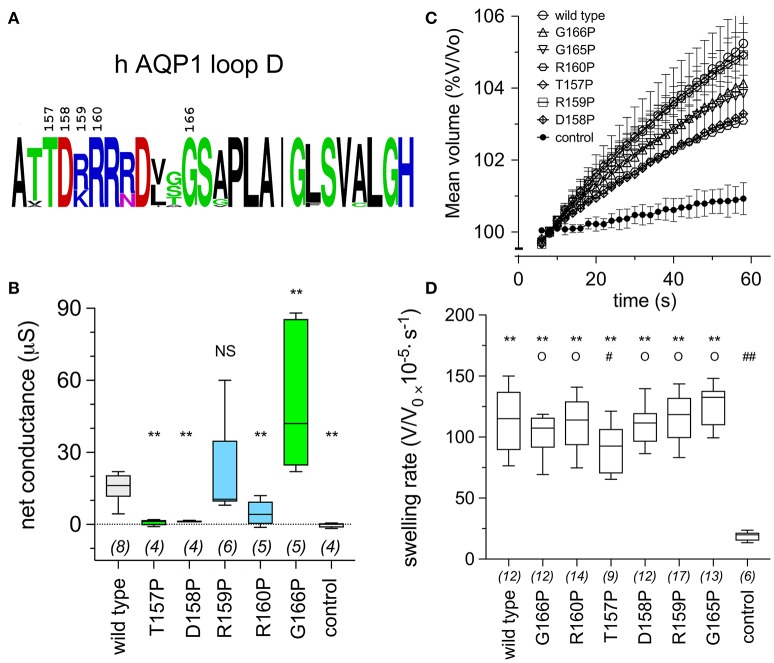
Conserved amino acids in the AQP1 loop D domain influence the ion conductance response, as assessed by proline mutagenesis. (A) Schematic summary of the level of conservation of loop D amino acids in AQP1 sequences (data shown in Figure 4) created with the online WebLogo tool (http://weblogo.berkeley.edu/logo.cgi). Letter sizes represent corresponding relative frequencies of occurrence at that position in the sequence set. (B) Box plot data showing the net conductance values (maximal—initial) for hAQP1 wild type and proline substituted mutant channels. Position-specific effects of proline-scanning mutagenesis on ion conductance responses in human AQP1 suggested less conserved positions are more tolerant of proline substitution. Statistical significance was evaluated with ANOVA and post-hoc two-tailed Mann Whitney. **p < 0.01; NS not significant, as compared with wild type; n values are above the x-axis. (C) Graph of mean volumes measured during optical swelling assays and standardized as a percentage of initial volume, for control oocytes and oocytes expressing wild type hAQP1 and proline-substituted mutants as a function of time after introduction of the oocyte into 50% hypotonic saline at time zero. (n values given in D). (D) Box plot histogram of swelling rates for hAQP1 wild type, proline mutant and control oocytes. Significant differences were determined by ANOVA (p < 0.0001) and post-hoc unpaired T-tests. ** indicates a significant difference from control, p < 0.0001. O indicates no significant difference from wild type, p > 0.05. A significant difference from wild type is indicated as # at p < 0.05, or ## for p < 0.0001.